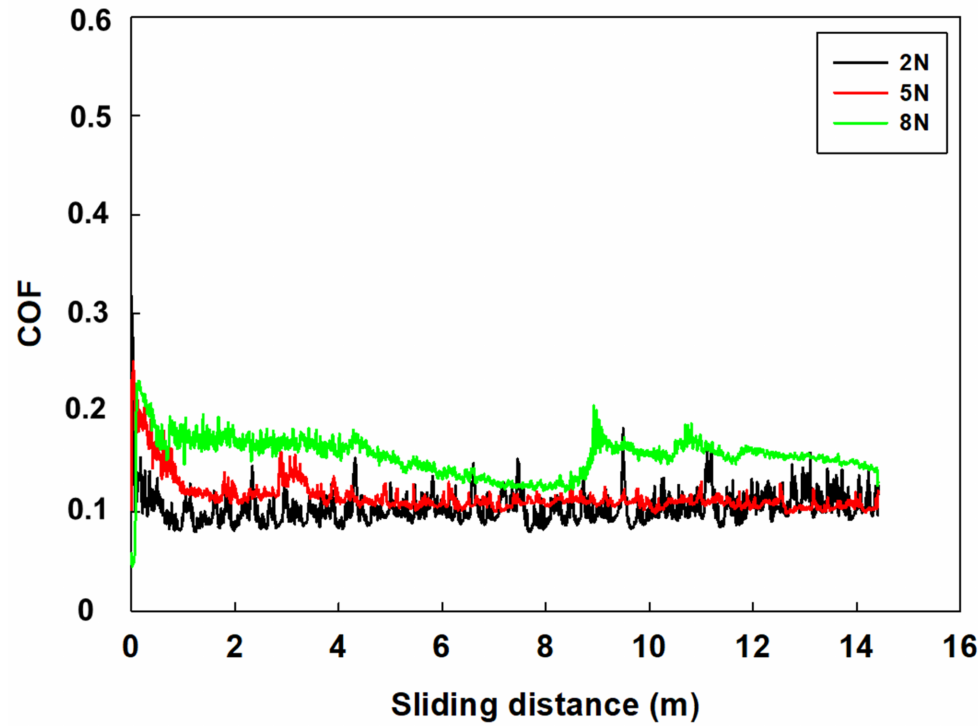
Figure 5. Coefficient of friction of AZ31 magnesium alloys as function of the applied normal load during wet sliding wear in 0.05 M